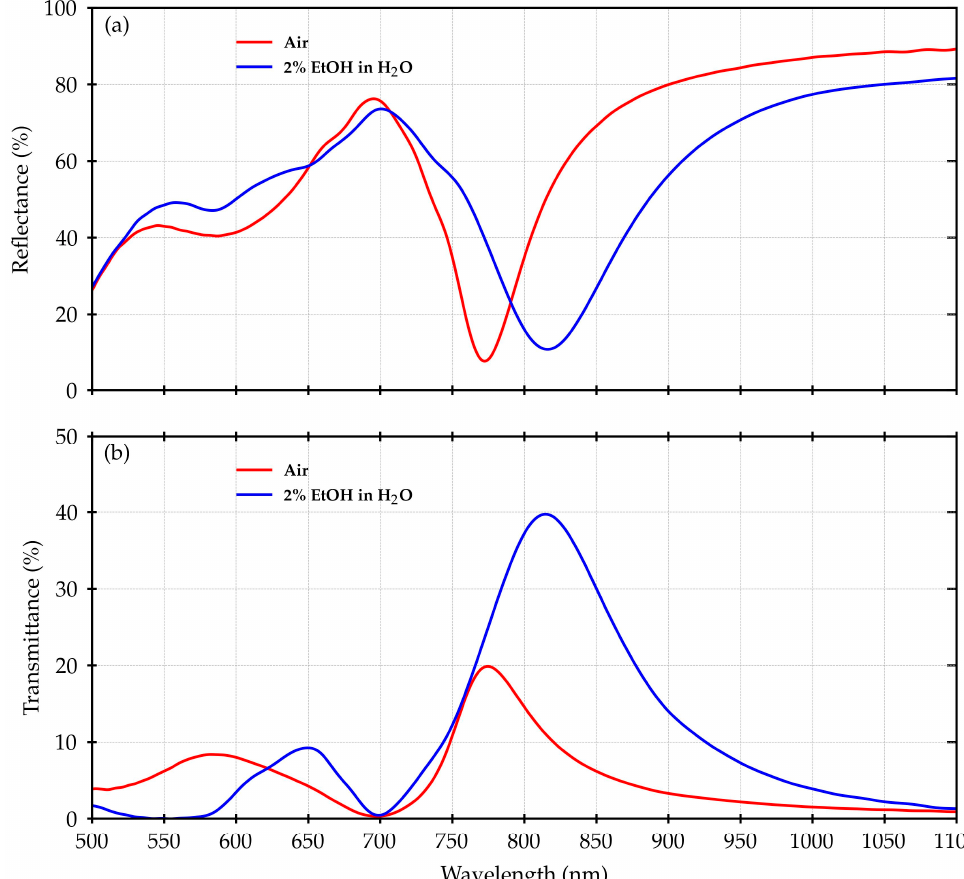
Figure 2. Comparison between experimental spectra acquired with the sample in air and embedded in a microfluidic cell with a 2% EtOH in water solution: ( a ) R spectra measured with an incidence angle of 2 degrees; ( b ) normal incidence T spectra.